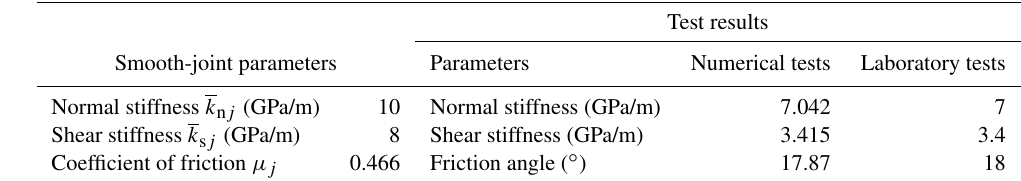
Table 4. Calibrated smooth-joint parameters and results of numerical and laboratory tests.